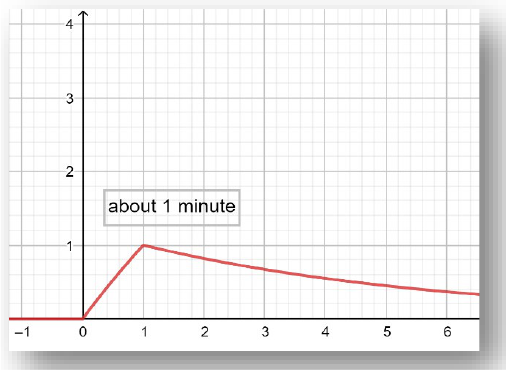
Figure 5. The fuzzy number “ about 1 min ” according to F(x) Figure 5 . The fuzzy number “about 1 min” according to F(x).